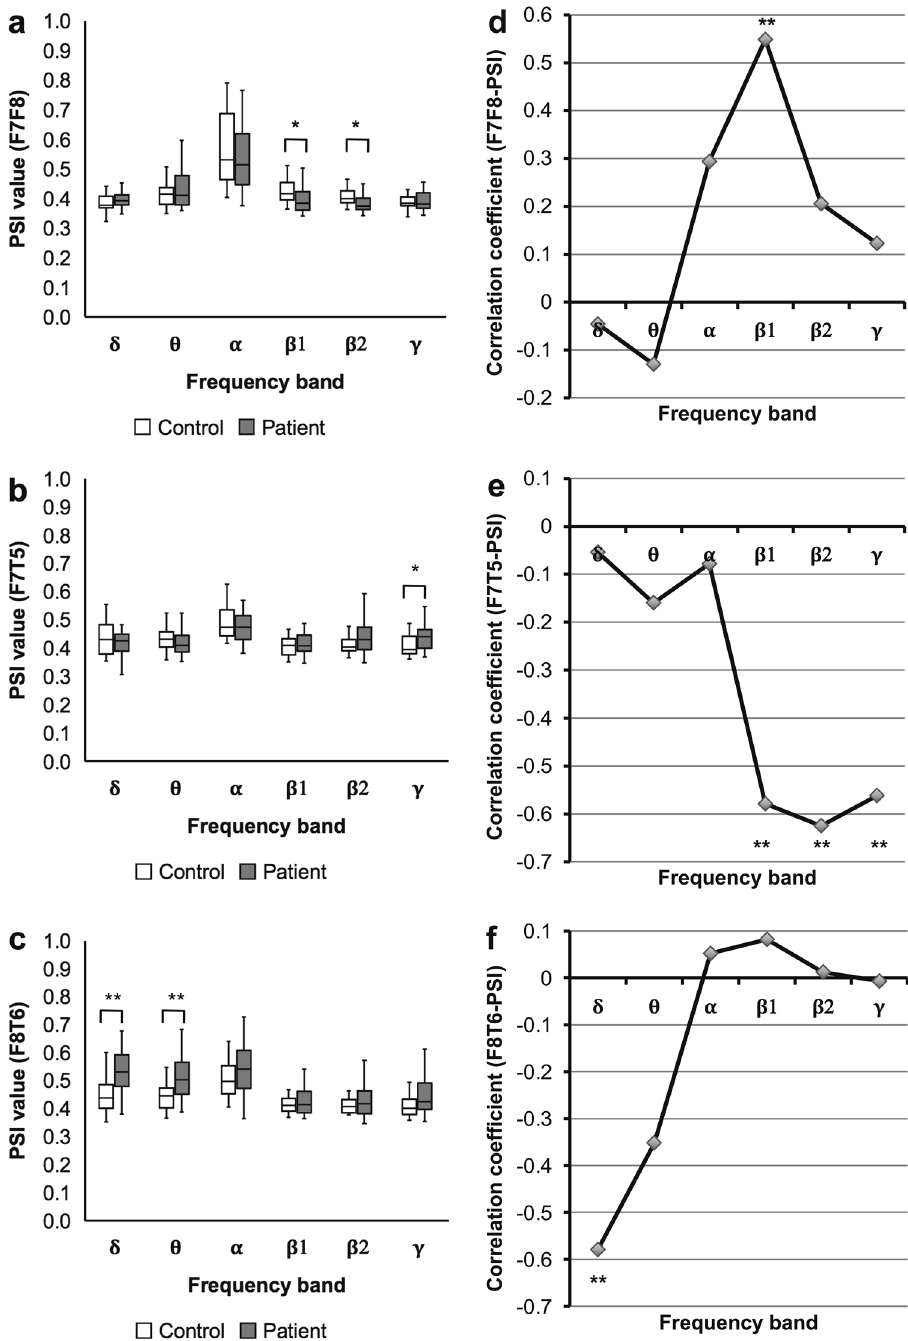
Figure 2. Results of analyses for the PSIs between the motor language-related regions. Comparison of PSIs in stroke patients with those in healthy controls. A box-and-whisker plot indicating values of the ( a ) F7F8-PSI, ( b ) F7T5-PSI, and ( c ) F8T6-PSI of stroke patients and healthy controls (Mann ‒ Whitney U test; * P < 0.05; ** P < 0.01, FDR corrected). The F7F8-PSI (β1 and β2), the F7T5-PSI (γ), and the F8T6-PSI (δ and θ) show significant differences between stroke patients and healthy controls. Correlation coefficients of the F7F8/F7T5/ F8T6-PSIs with ARSsp scores. A polygonal line graph of the correlation coefficients for the correlation of ( d ) F7F8-PSI, ( e ) F7T5-PSI, and ( f ) F8T6-PSI with ARSsp scores (Spearman’s correlation analysis; * P < 0.05; ** P < 0.01, FDR corrected). Each PSI shows significant correlations in distinct frequency bands with significant differences between stroke patients and healthy controls. ARSsp Aphasia Rating Scale speech, FDR false discovery rate, PSI phase synchrony